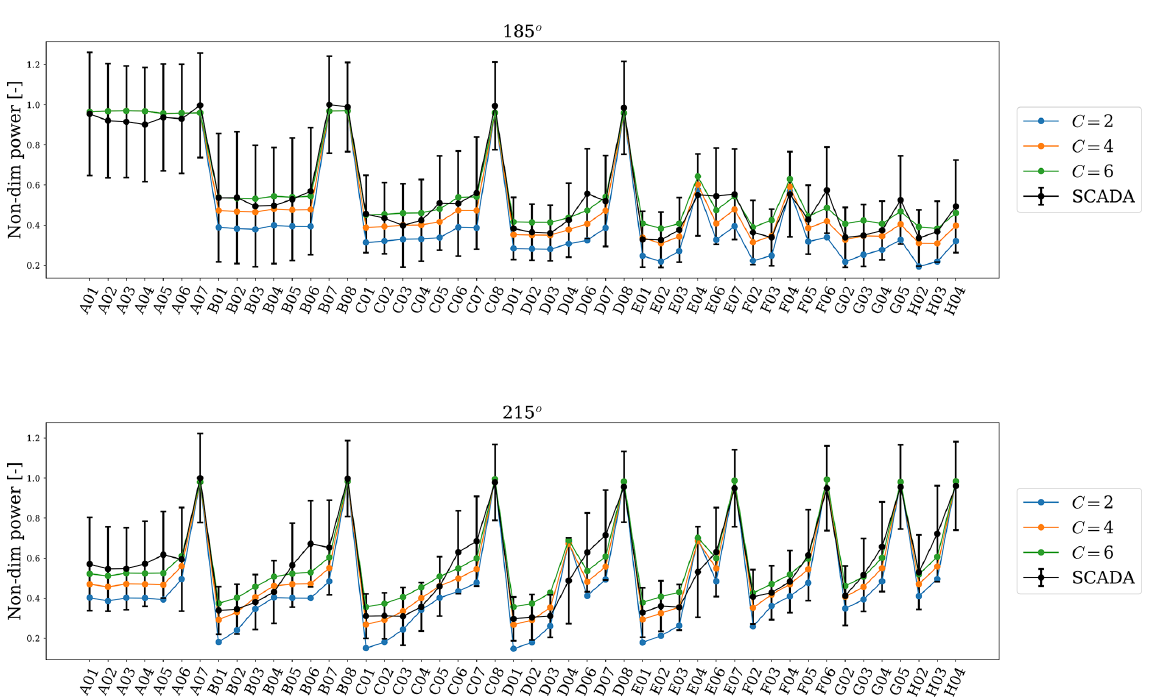
Figure A1. Comparison of turbine power versus SCADA data for the Lillgrund wind plant for cases at two different wind directions (185, 215 ◦ ). Different lines denote values of the constant C used to scale the viscous term in the